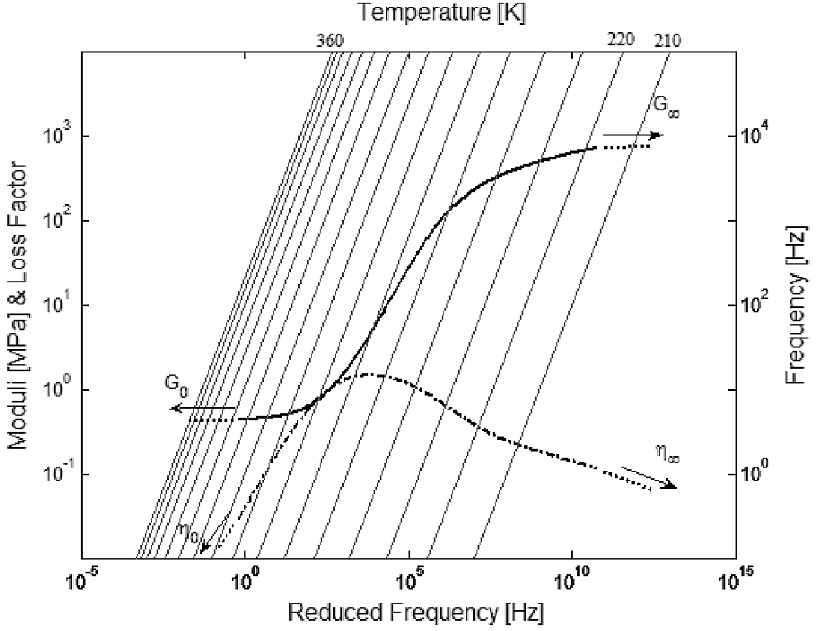
Fig. 3. Illustration of the asymptotic properties of storage modulus and loss